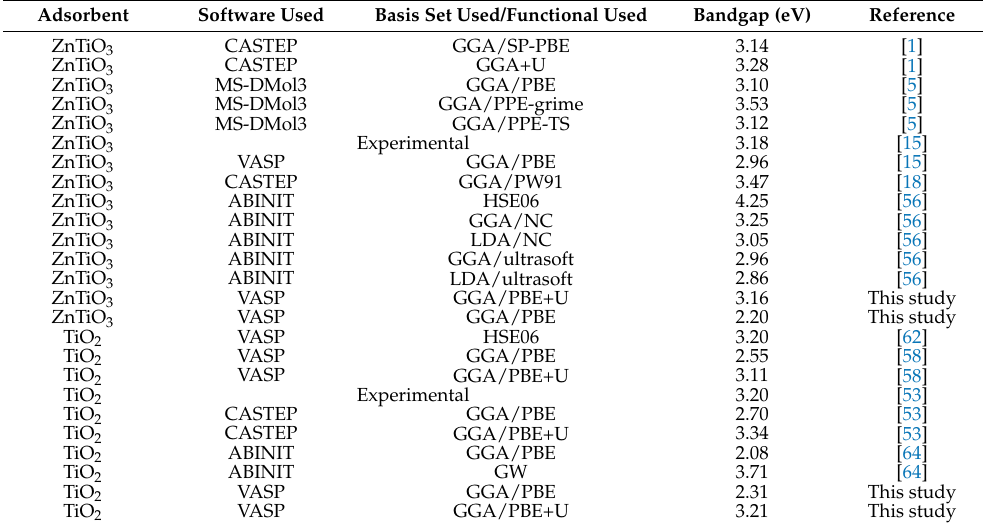
Table 1. Calculated bandgap energy of ZnTiO 3 and TiO 2 and other values reported in the literature. Adsorbent Software Used Basis Set Used/Functional